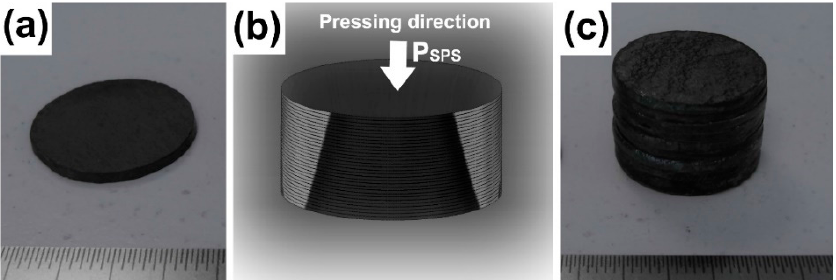
Figure 1. Fabrication of thick Ca 3 Co 4 O 9 ceramics with spark plasma sintering (SPS) and spark plasma texturing (SPT) processes. ( a ) SPS-processed single pellet with 2 mm in thickness. ( b ) Schematic of a